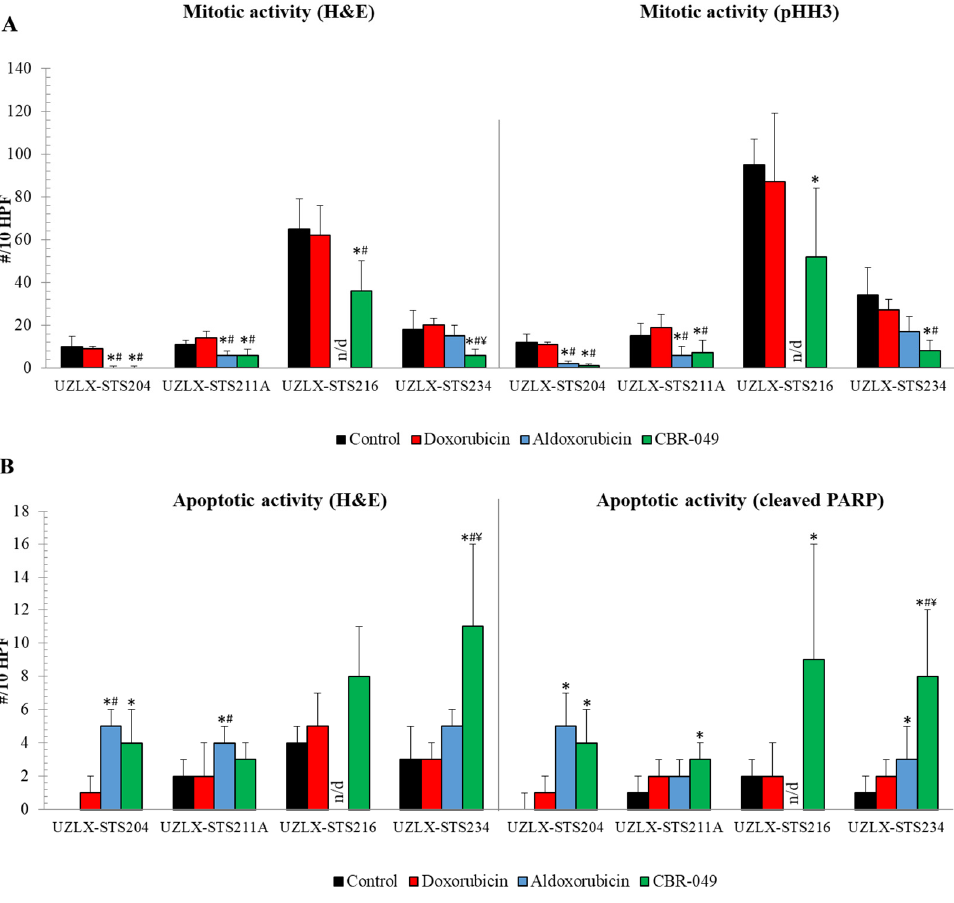
Figure 5. Assessment of mitotic and apoptotic activity of tumors collected on day 29 of the experiment. ( A ) Mitotic cell count assessed on H&E and pHH3 staining; ( B ) apoptotic cell count assessed on H&E and cleaved PARP staining. Data are presented as average ± standard deviation. Aldoxo-treated samples from UZLX-STS216 could not be assessed as they were too small to count 10 HPF. * p < 0.05 as compared to control; # p < 0.05 as compared to doxorubicin; ¥ p < 0.05 as compared to aldoxorubicin. H&E: hematoxylin and eosin; pHH3: phospho-histone H3; PARP: poly (ADP-ribose) polymerase; HPF: high power